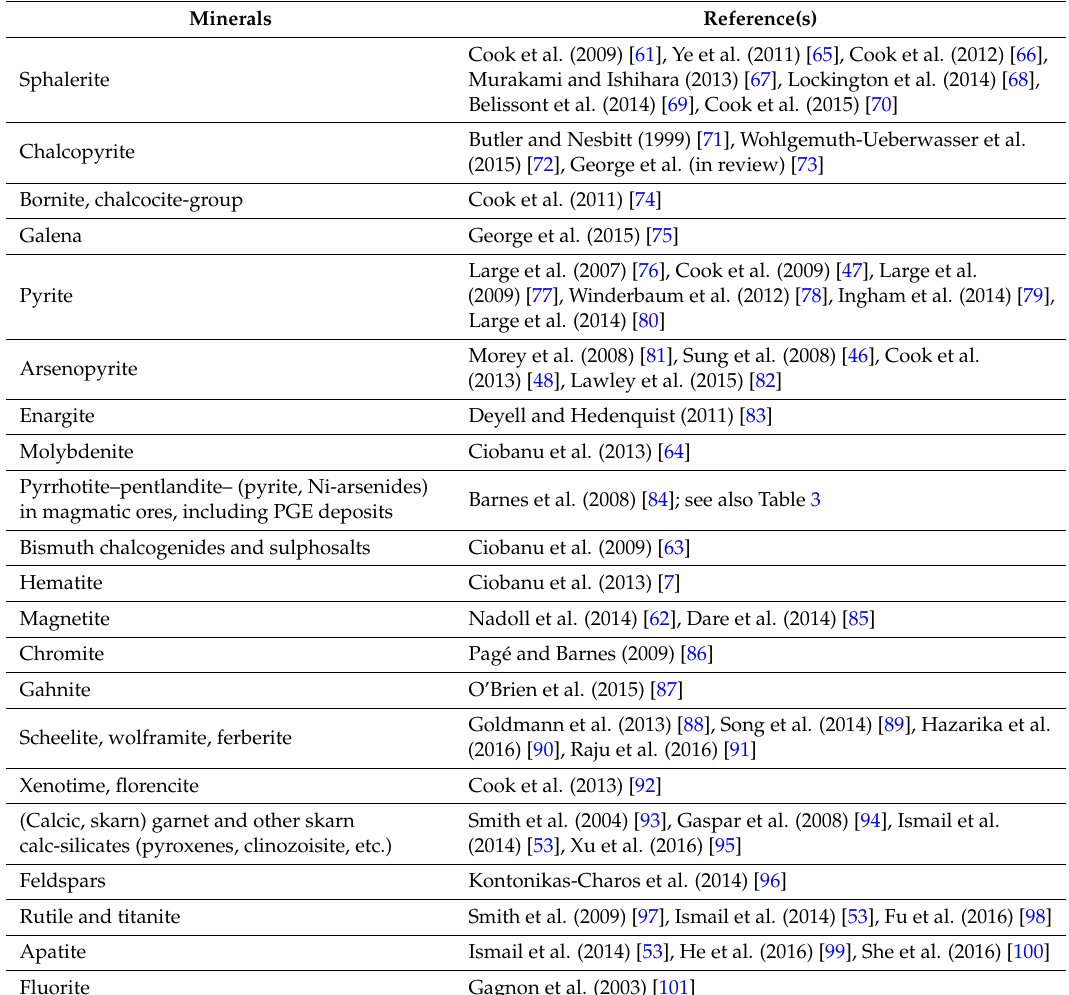
Table 2. Selected studies that have used LA-ICP-MS to address the trace element geochemistry of common sulphides, iron-oxides, rock-forming silicates and accessory